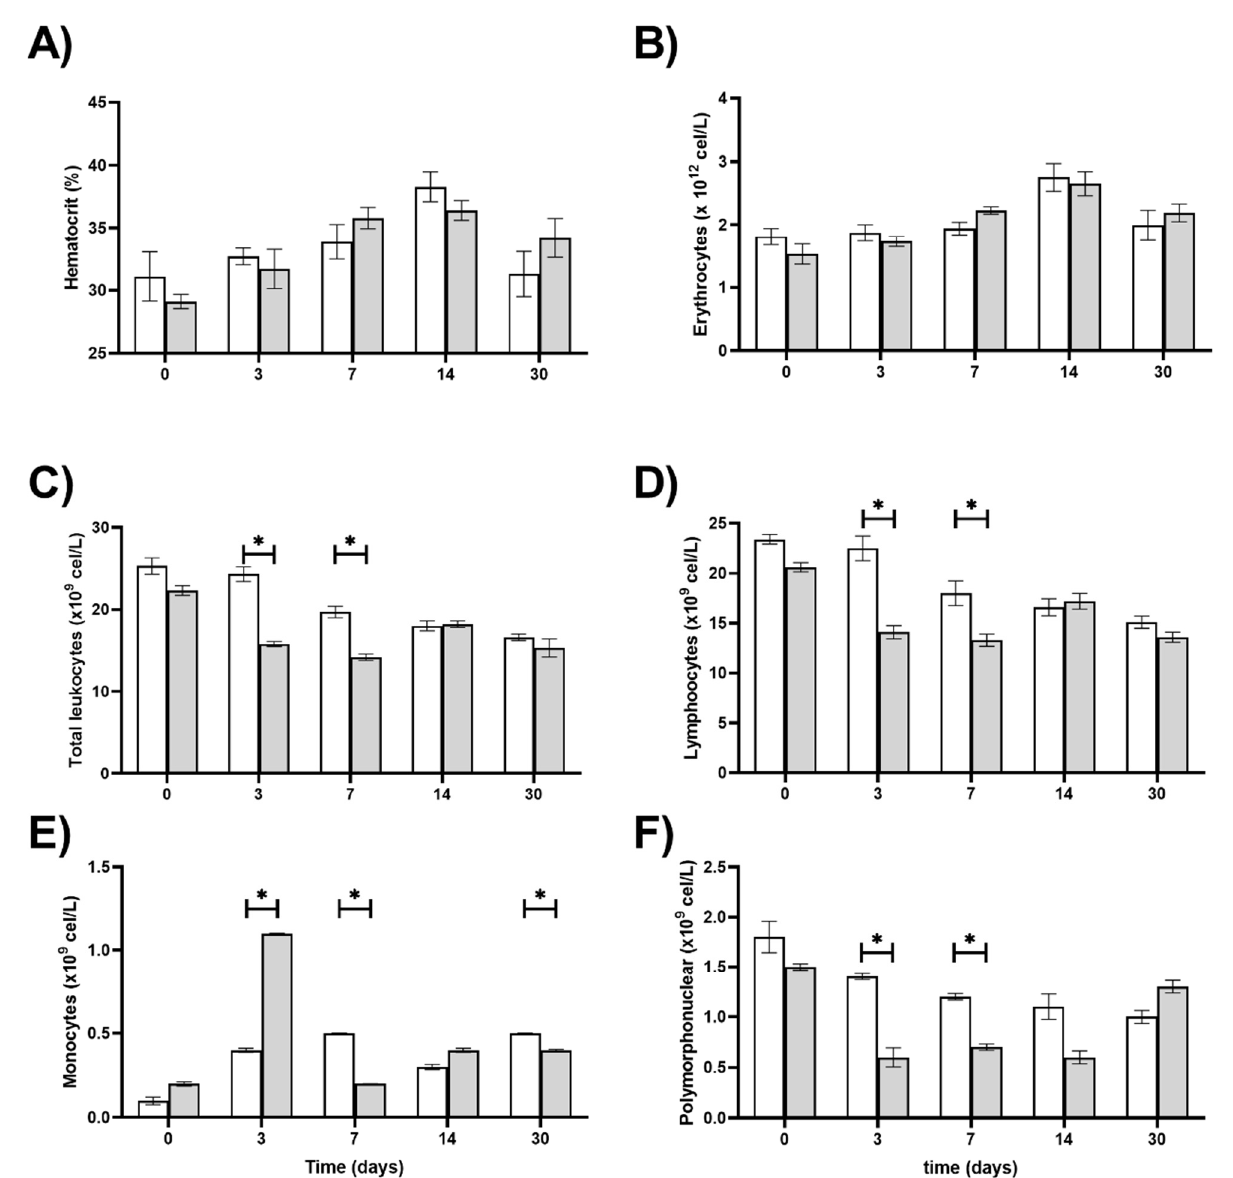
Figure 2. Changes in Haematocrit ( A ), Erythrocytes ( B ) and Leucocytes ( C ), Lymphocytes ( D ), Monocytes ( E ) and Polymorphonuclear ( F ) in trout ( O. mykiss ) exposed to control (natural photoperiod; empty bars) and artificial (LD24:0; grey bars) photoperiods. Asterisks indicate significant differences between treatments. Bars represent mean and ± Standard Error.